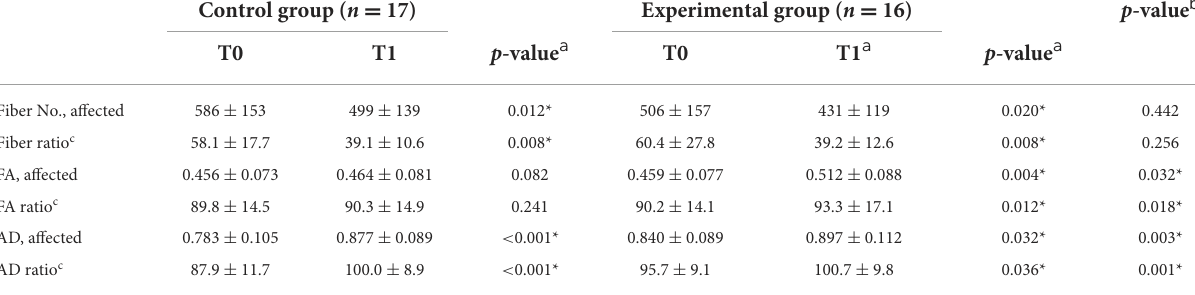
TABLE 3 Comparison of diffusion tensor tractography parameters in both groups after 4-weeks intervention. Control group ( n = 17)